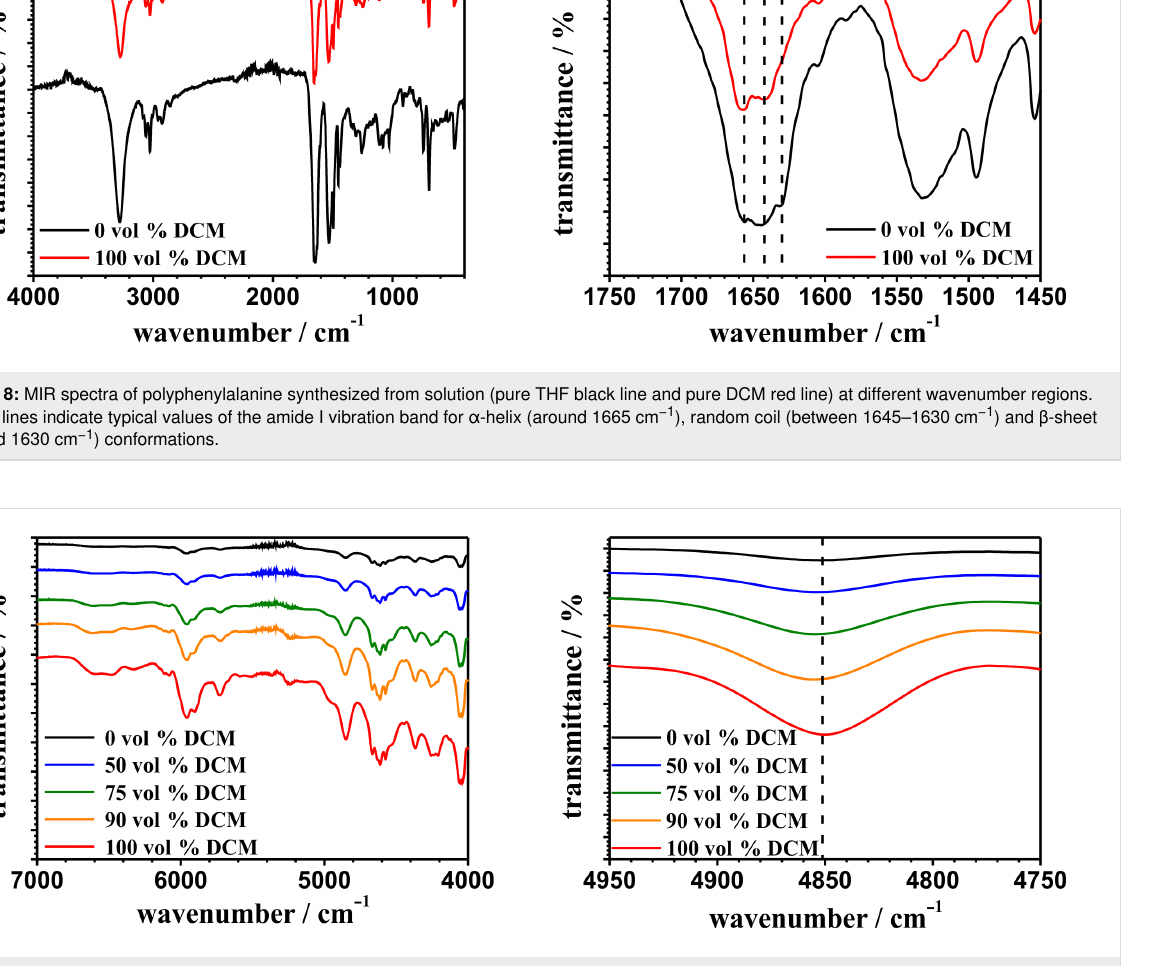
Figure 9: NIR spectra of the polyphenylalanine functionalized ALOX-membranes from different solvent mixtures at different wavenumber regions after treatment with CHCl 3 /DCA. Dotted lines indicate the maxima of the combination band at 4850 cm − 1 of the polyphenylalanine functionalized ALOX- membrane from pure